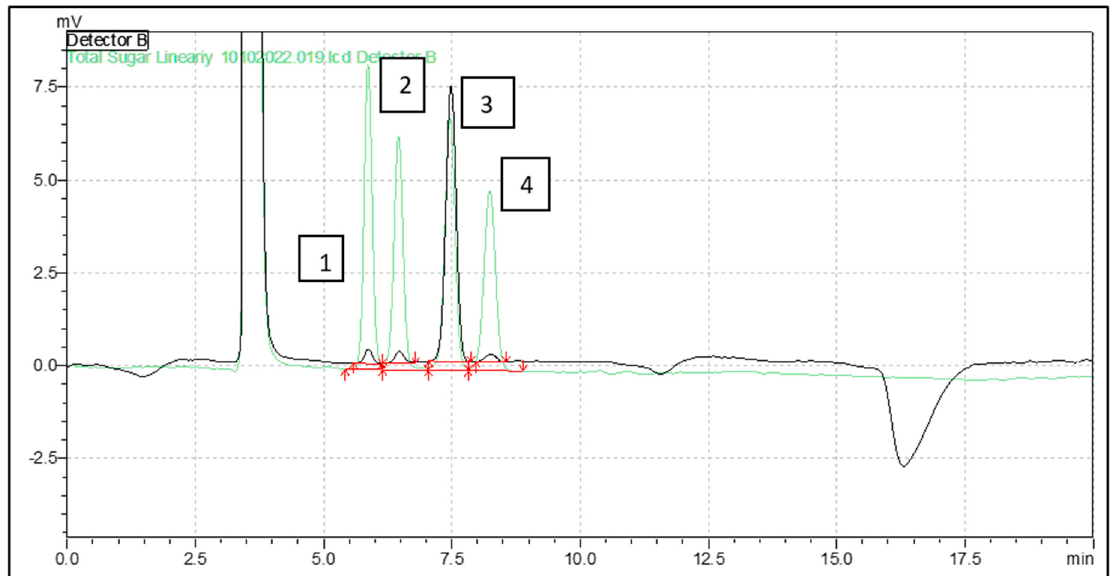
Figure 2. Chromatogram of Sugars in the Eggless Mayonnaise Sample ( 1 ) Fructose, ( 2 ) Glucose, ( 3 ) Sucrose, ( 4 ) Lactose.